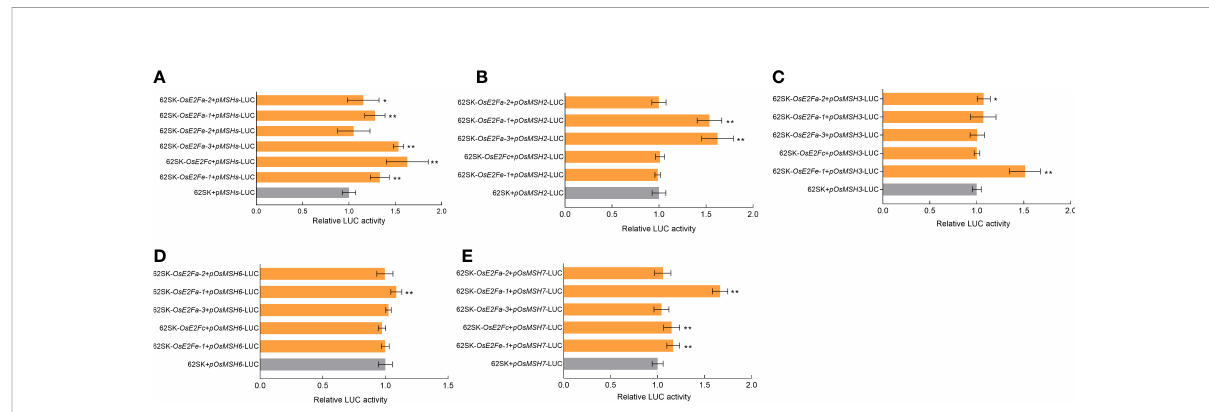
FIGURE 2 (A) LUC activation of OsE2Fs and MSHs. (B-E) LUC activation of OsE2Fs with OsMSH2,OsMSH3,OsMSH6 and OsMSH7, respectively. Transient dual luciferase reporter analysis indicates that E2Fs can activate MSHs. 62SK represents empty pGreenII 62-SK vector. 62SK-OsE2F represents the pGreenII 62-SK-OsE2F vector. pMSH-LUC represents pGreenII 0800-pMSH-LUC vector. Renilla luciferase (REN) was used for normalization. Results shown are means G SD (n = 9). Asterisks show signi fi cant differences from the control (Student ’ s t-test, p < 0.05). * indicates p<0.05, ** indicates